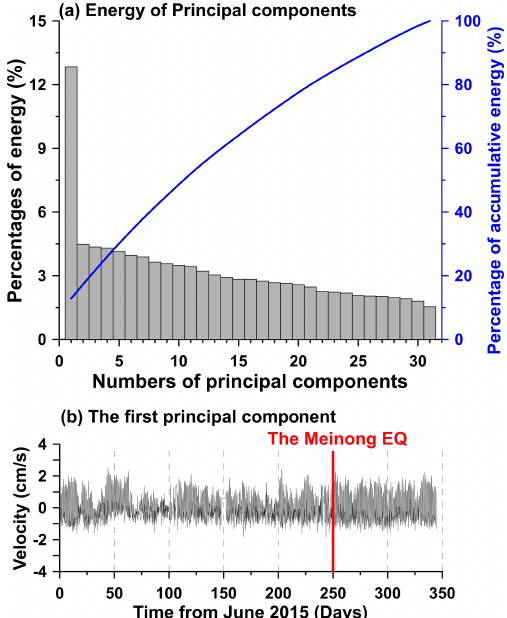
Figure 3. The energy and the first principal component derived from vertical seismic velocity data from the 31 stations. The energy and the cumulative energy of the principal components are shown in (a) . Bars denote the energy of each principal component. The blue line shows the variation in the cumulative energy from dis- tinct used principal components. The variations in the first principal component during the period (i.e., from June 2015 to June 2016) are revealed in (b) . The red vertical line indicates the occurrence time of the M 6 . 6 Meinong earthquake (on 2 February